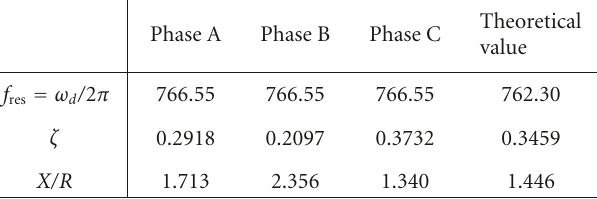
Table 6: Estimation results with unbalanced lines and loads.